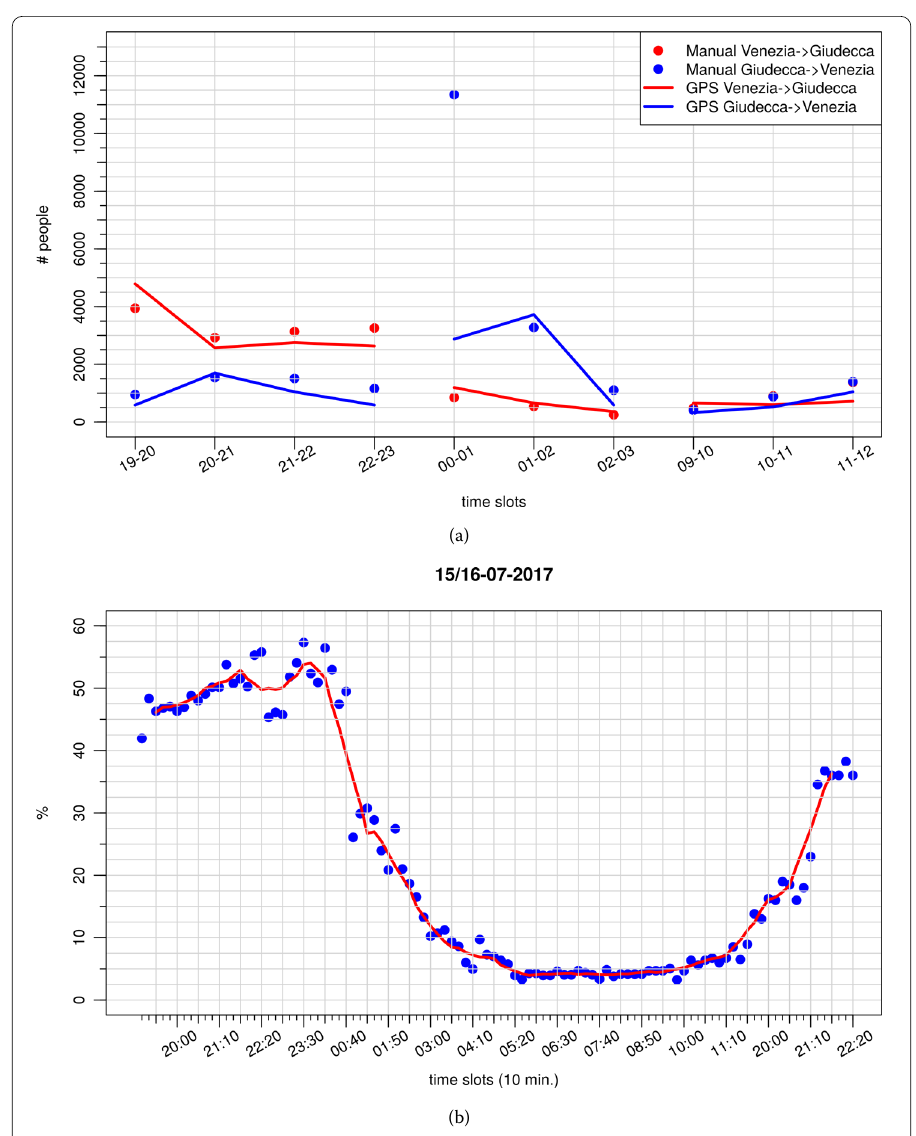
Figure 2 Left picture: comparison of the hourly pedestrian flows on the Redentore bridge estimated from the GPS dataset (continuous curves) and the empirical measures by a direct people counting (dots) performed by volunteers: the blue data refer to the pedestrian flow from Giudecca island toward Venice centreThe historical centre of Venice is an ideal experimental field to study the features of pedestrian mobility and the choice of two big tourist events (the Carnival of Venice 2017 and the FestadelRedentore ) as case studies allows on one hand to increase the representativeness of the sample and on the other hand to provide quantitative information to the stakeholders that are in charge of the management of tourist flows., whereas the red data refer to the pedestrian flow on the opposite direction. The scaling factor applied to the sample of the GPS dataset corresponds to a penetration of 1.6%. We recall that the bridge was closed between 23:00 p.m. and 12:30 a.m. Right picture: empirical relative frequency to get a GPS record near the Redentore bridge in a time interval of 10 minutes from a device in the selected sample; the red line is a running average over one hour to smooth the fluctuations effect